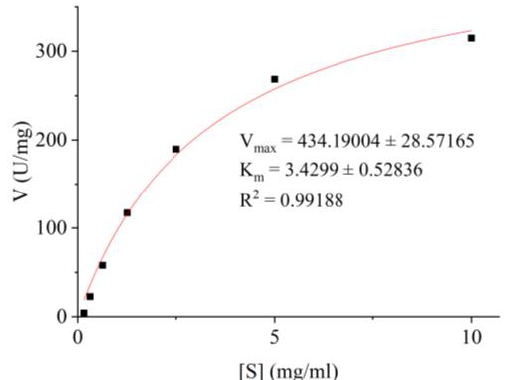
Figure 15. Saturation curve of varying starch concentration. The abscissa represents the starch concentration while the ordinate represents the velocity of reducing sugar yield. The initial velocities of the α -amylase activity were determined by the DNS method under 70 ◦ C, pH 6.0 and 20 min. All assays were repeated four times. The reduced sugar produced after the reaction was calculated with a maltose standard curve. The initial velocities were expressed as µ M maltose generated per minute per mg purified protein. The kinetic parameters K m and V max of the BvAmylase were obtained by using the non-linear regression function Michaelis Menten in the software OriginPro